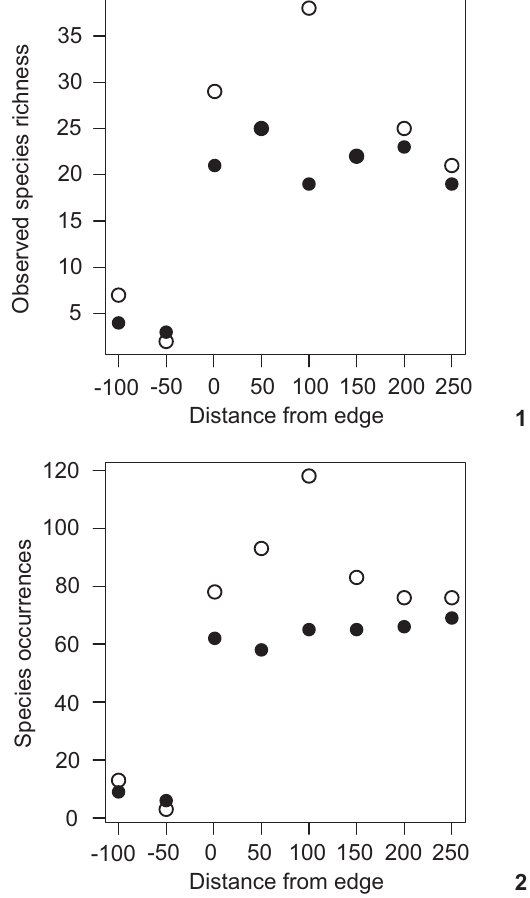
Figures 1-2. Relationships between distance from edge and: ob- served species (1) and species occurrences (2) for ground-dwell- ing ant assemblages in two surveyed Cerrado reserves. (  ) re- serve 1, (  ) reserve 2, in Balsas, Maranhão, northern